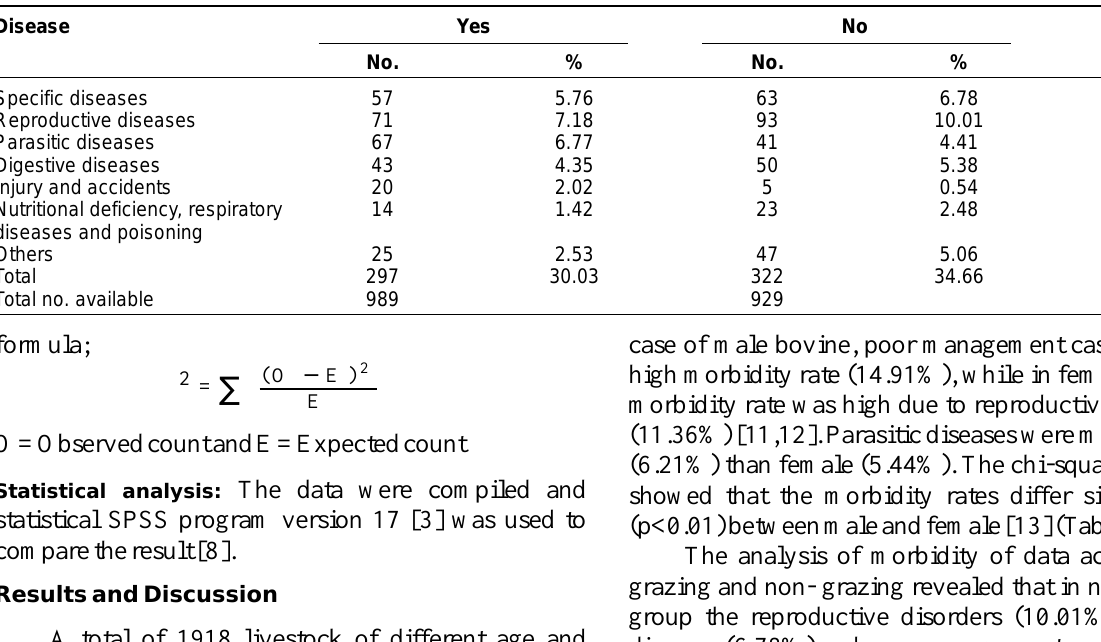
Table-1.3. Feeding management factor (Grazing) wise morbidity rate in